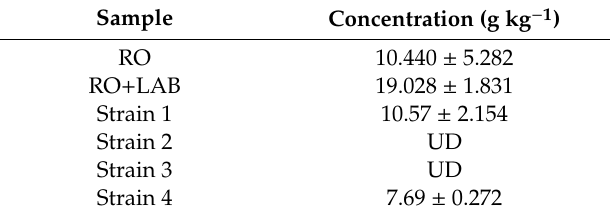
Table 2. Contents of γ -aminobutyric acid (GABA) detected by HPLC in di ff erent red-bean tempeh samples by using 6 di ff erent strains.